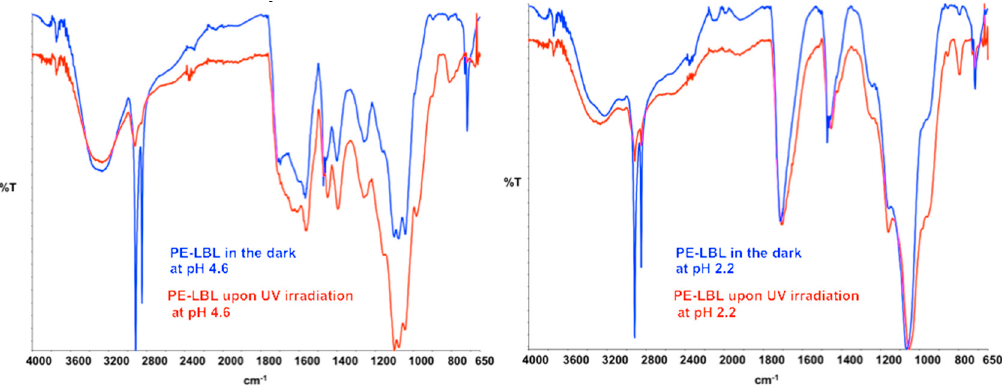
Figure 5. ATR spectra collected onto PE-LBL membranes after incubation in the dark and upon UV light irradiation. light